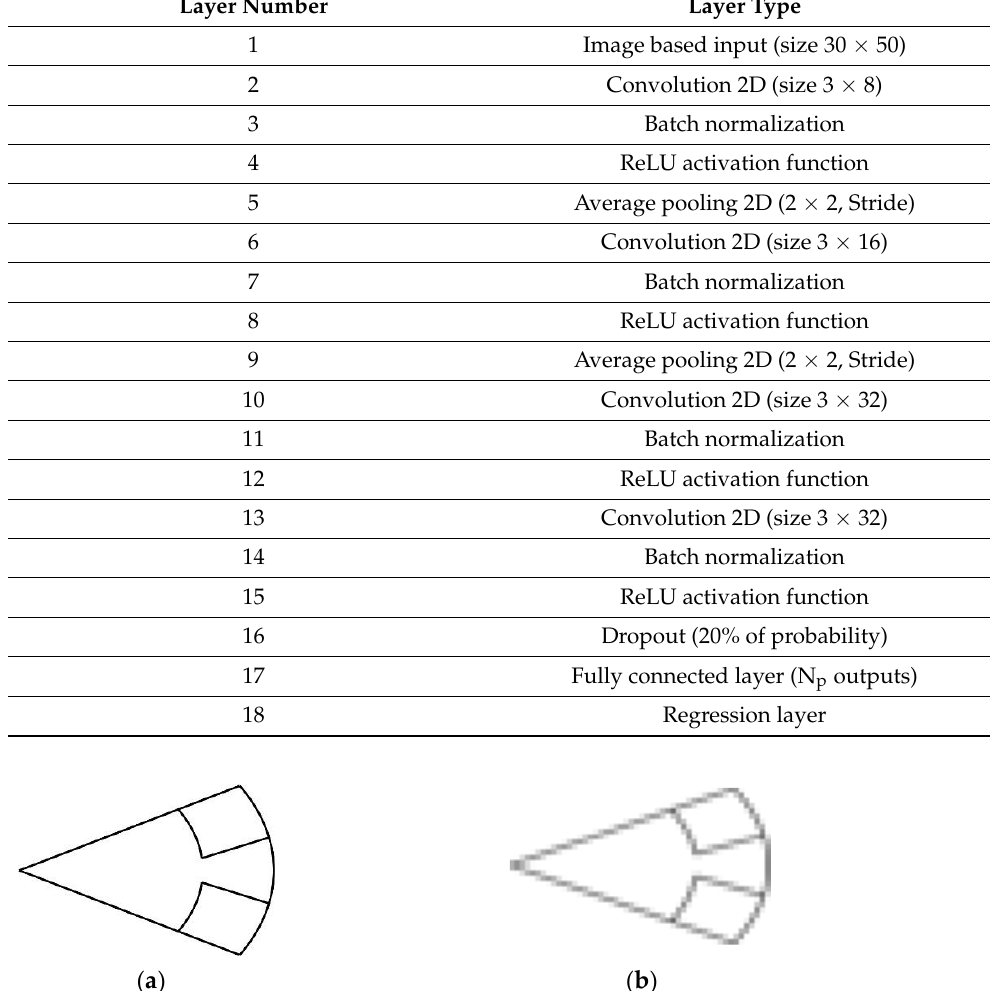
Figure 3. Image of the circular sector of the rotor: full resolution ( a ), 30 × 50 pixels resolution ( b